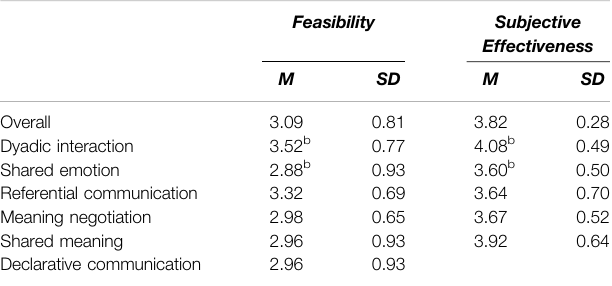
TABLE 4 | Scores on the Feasibility and the Subjective Effectiveness subscales of the Social Validity Scale a .